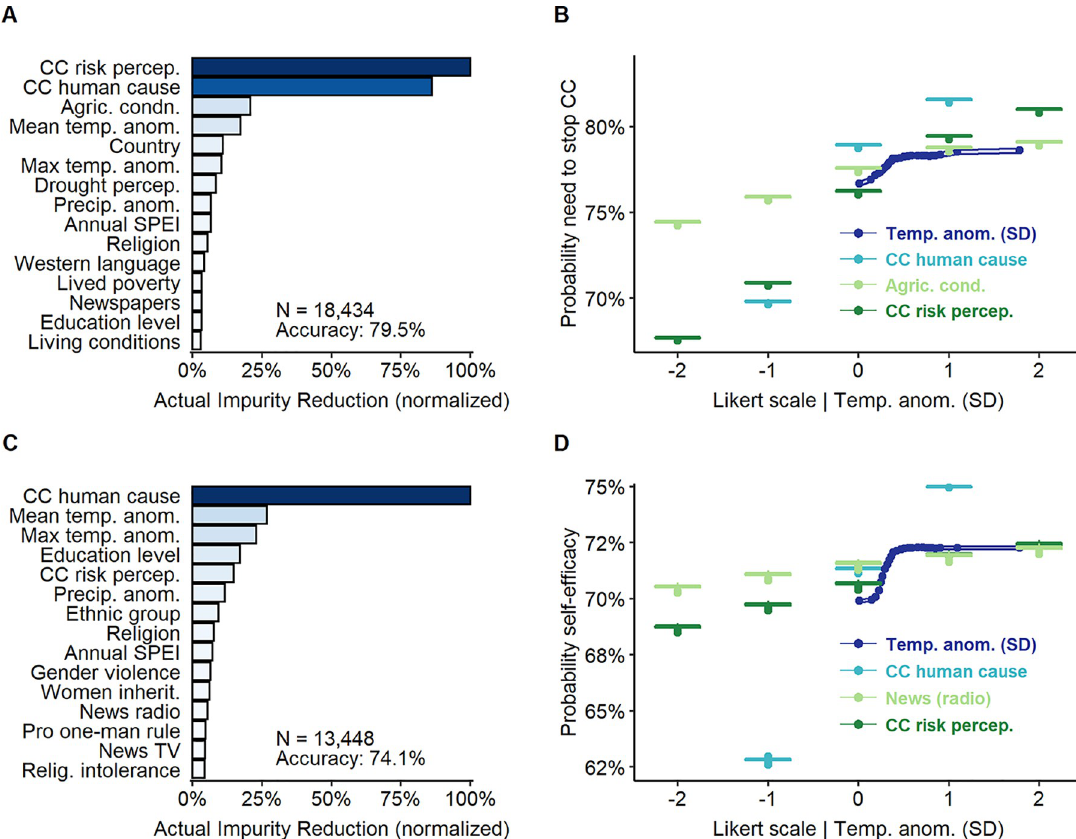
Fig 2. Key predictors of need to stop climate change and self-efficacy. Top 15 predictors of need to stop climate change (A) (79.5% prediction accuracy) and self-efficacy (C) (74.1% prediction accuracy). (B) Partial dependence plot (PDP) of mean temperature anomalies ( temp . anom .), belief in human causation ( CC human cause ), perceived worsening of agricultural conditions ( agric . cond .), and perceived risk from climate change ( CC risk percep .) over need to stop climate change. (D) Partial dependence plot of mean temperature anomalies ( temp . anom .), belief in human causation ( CC human cause ), perceived risk from climate change ( CC risk percep .) and being favourable to one-man rule ( authoritarian ) over self-efficacy.